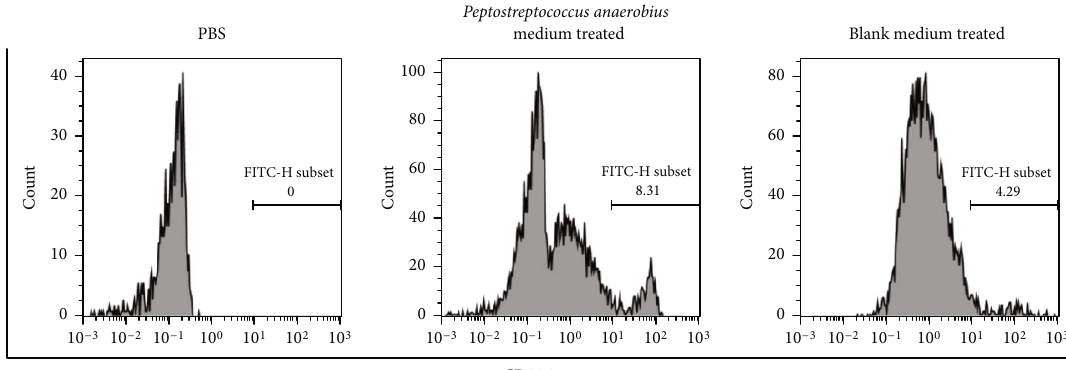
Figure 3: The e ff ect of Peptostreptococcus anaerobius upon the polarization of macrophages: the expression of CD206 (M2 macrophage markers) in THP-1 cells when treated with PBS or Peptostreptococcus anaerobius medium or blank medium.